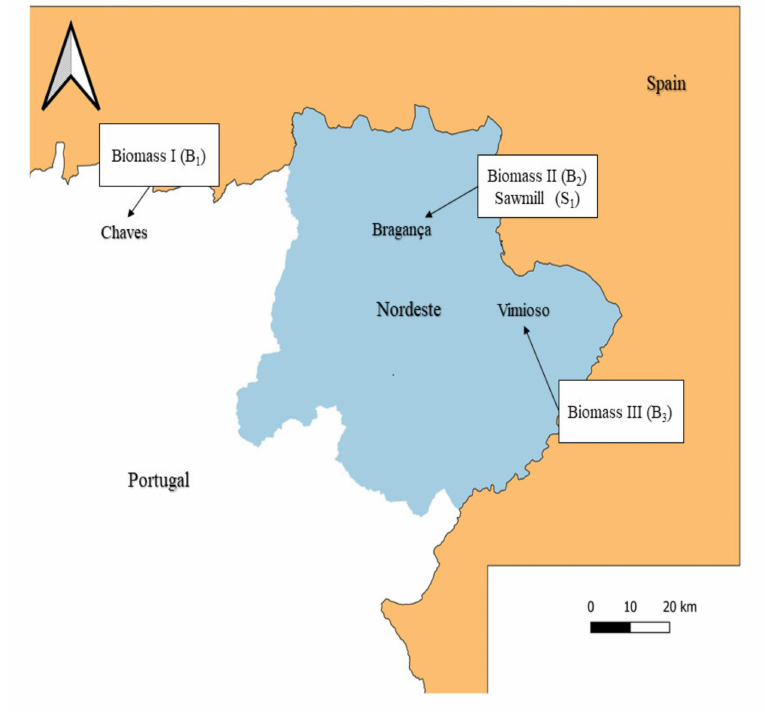
Figure 4. Location of forest industries considered in the 10 demand scenarios tested in the Nordeste region,